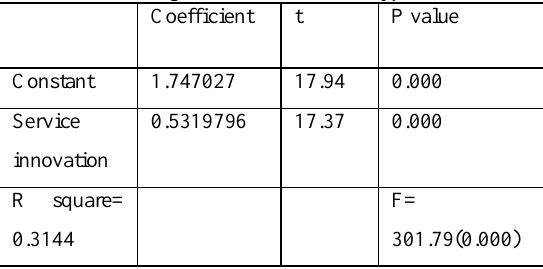
Table 1: Regression Results for Hypothesis 1